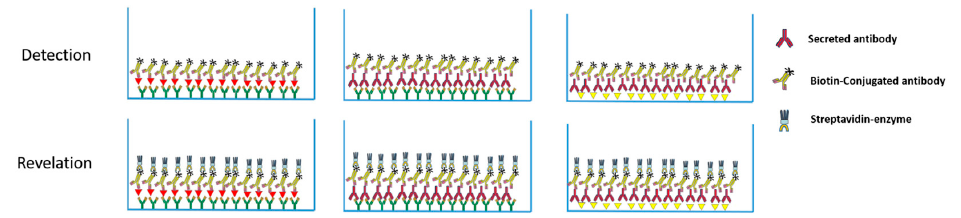
Figure 2. Schematic representation of the main steps on different Elispot categories used in the Tropical